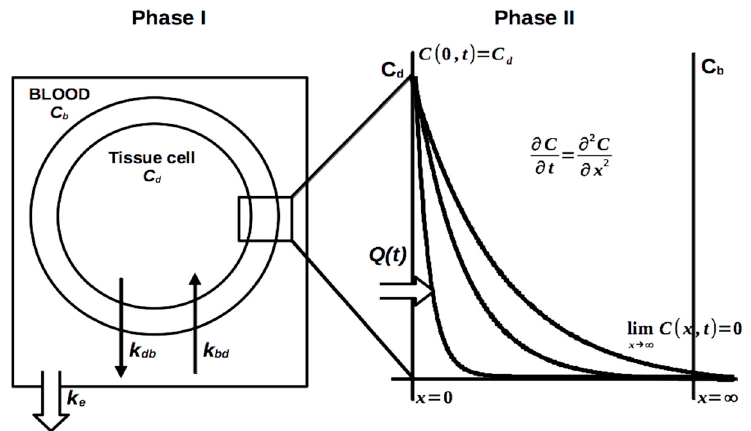
Figure 7. Bi-compartmental (i.e., blood to tissues) and diffusional models for 65 Zn decorporation following Zn-DTPA intervention.